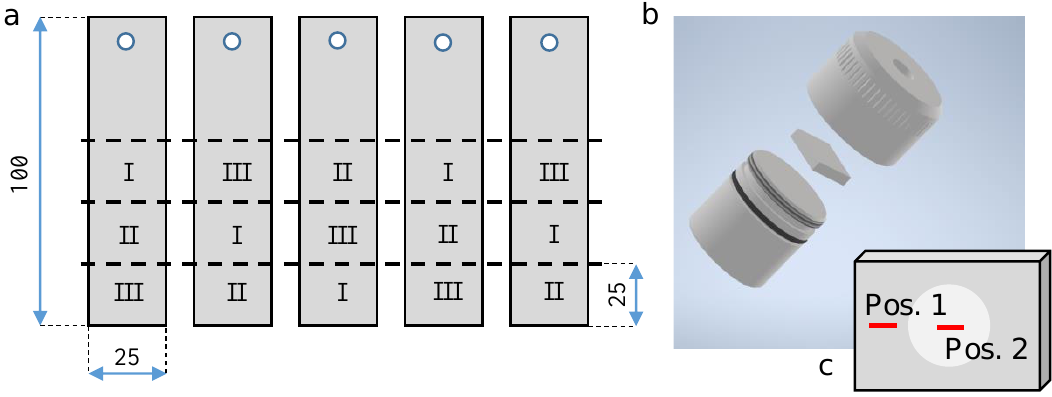
Figure 1. Schematic representation of the PEO-coated aluminum sheets, extraction positions of the individual samples and indication of the electrolytes (Table 2) used for exposition experiments ( a ) within a sample holder ( b ) as well as the position of the further SEM and EBSD investigations ( c ).